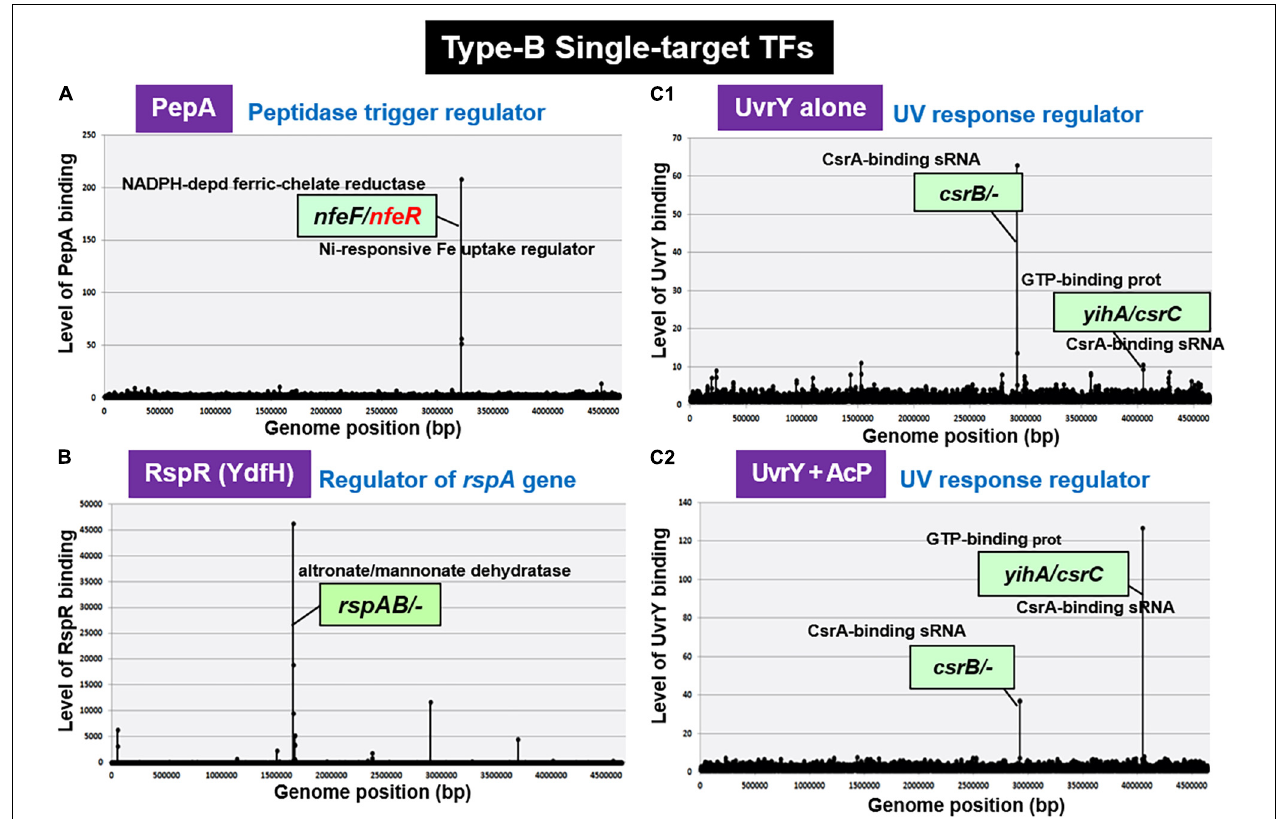
FIGURE 6 | gSELEX patterns of novel type-B ST-TFs. The ST-TF gene and its regulatory target gene(s) are located separately on the E. coli K-12 genome. (A) PepA binds to a single target inside the spacer between nfeF , which encodes a NADP-dependent ferric-chelate reductase, and nfeR , which encodes a Ni-responsive Fe 3 + uptake regulator. (B) RspR binds to a single target upstream of the rspAB , which encodes a predicted Zn 2 + -dependent D-mannose dehydrogenase. (C1,C2) UvrY recognizes and binds to the region upstream of csrB and the spacer region of yihA/csrC , but the binding affinity may shift depending on level of